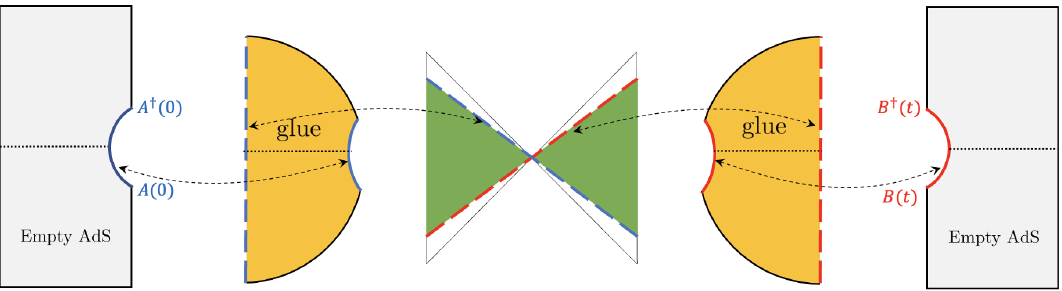
Figure 9 . Geometry that estimates the square of (3.6). The green region is the Lorentzian “bow tie” geometry. The yellow region is the region with negative Euclidean time. The grey region involves positive euclidean time. Solid or dashed lines of the same color are identified. The dotted black line represents a cross section of the